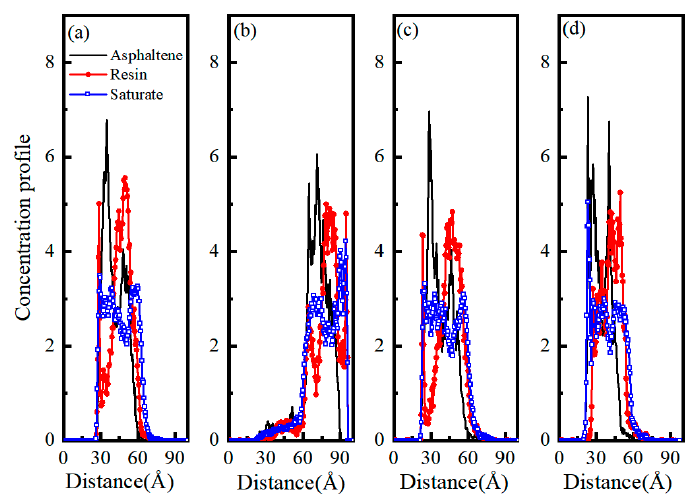
Figure 10. The concentration profiles for three components of asphalt along the vertical direction: ( a )